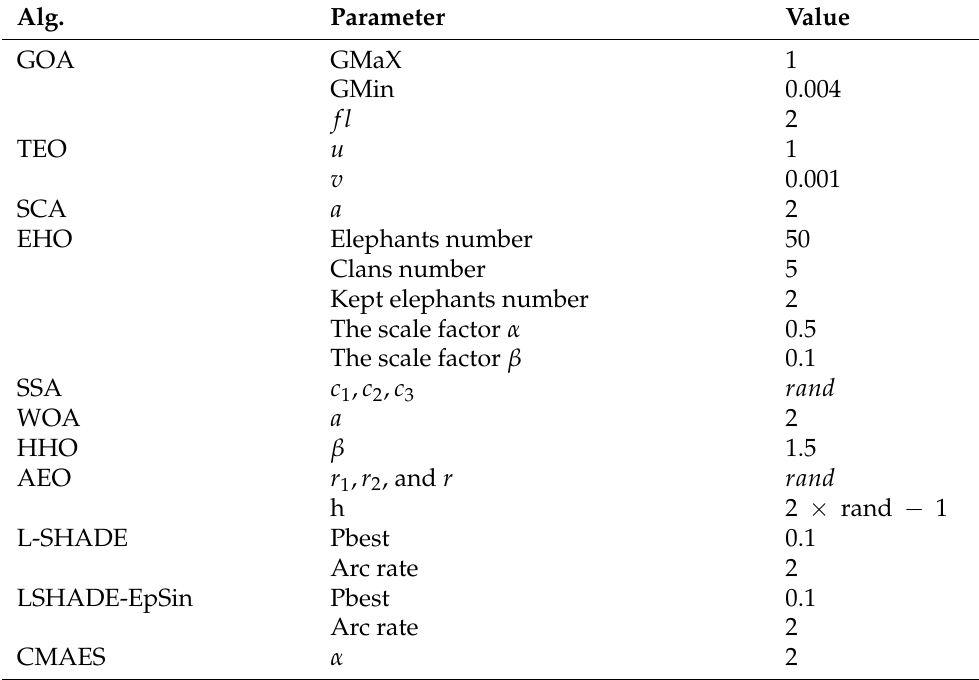
Table 3. Metaheuristic algorithms parameters